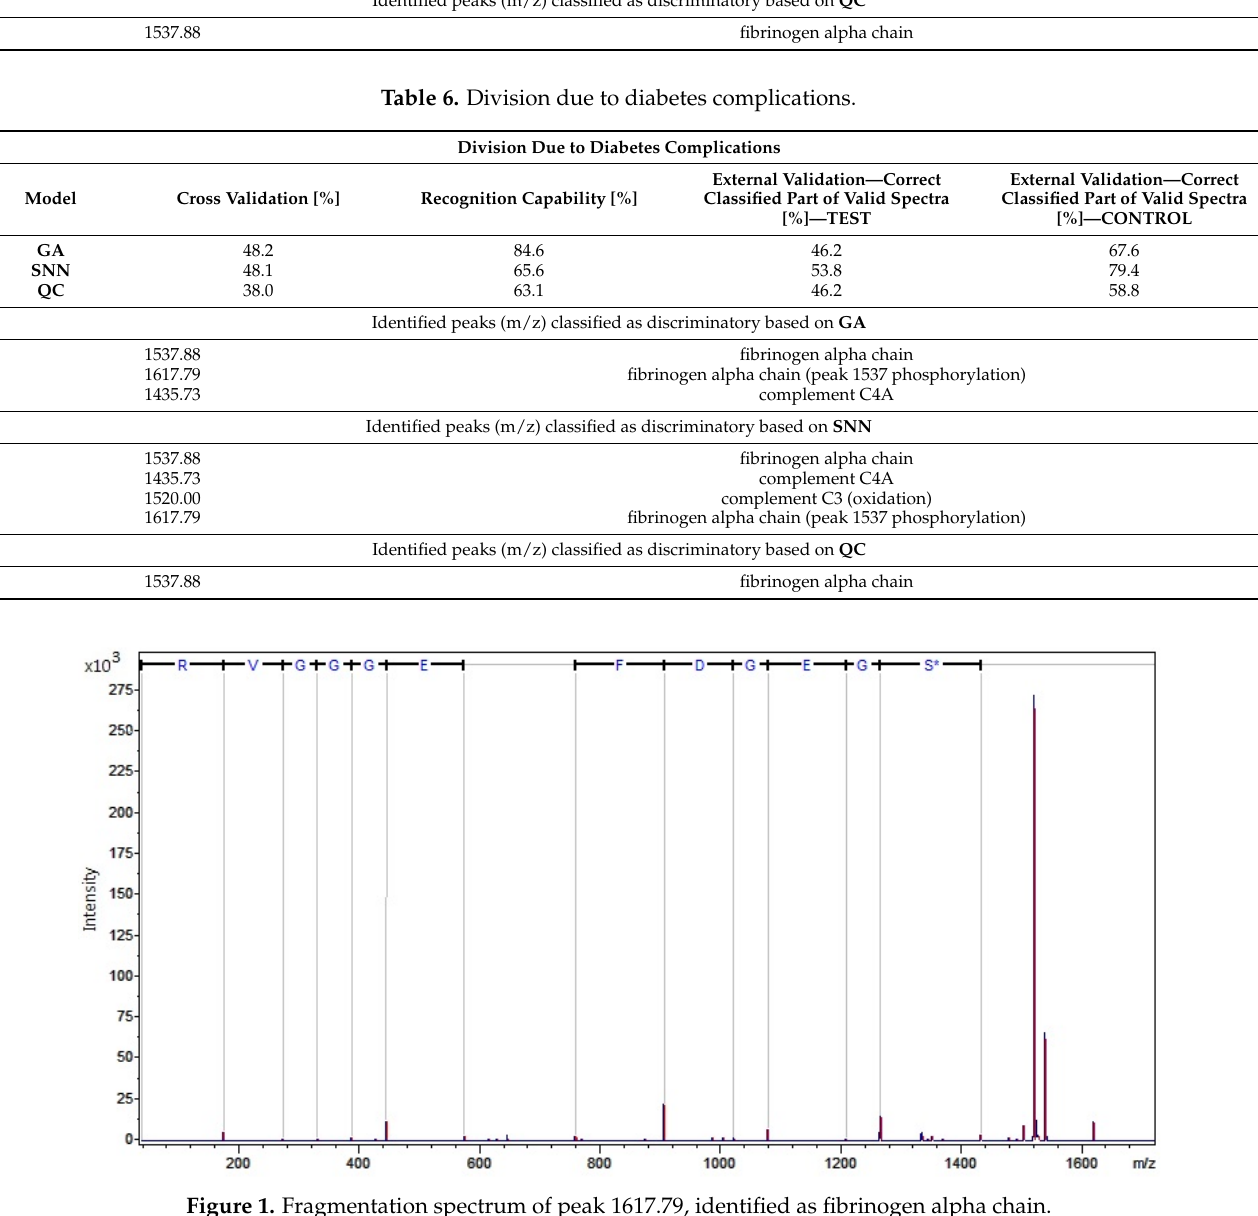
Figure 1. Fragmentation spectrum of peak 1617.79, identified as fibrinogen alpha